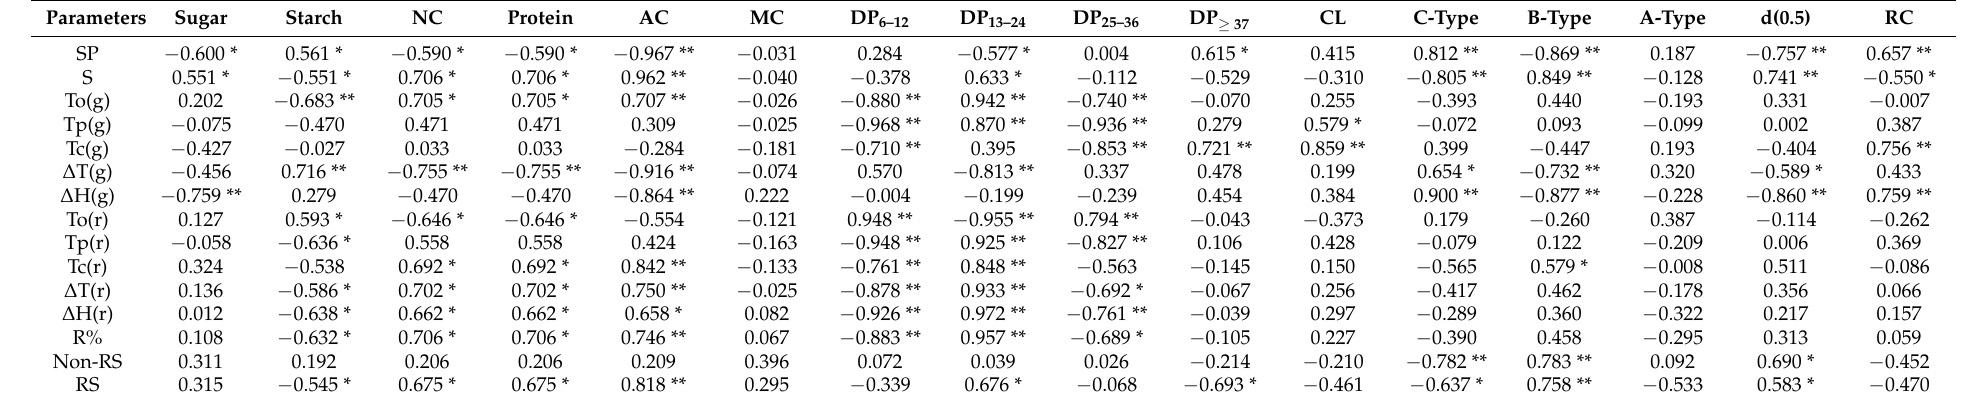
Table 7. Pearson’s correlation between the compositional and structural variables and the physicochemical and functional variables of the four Thai commercial rice starches with different pasting